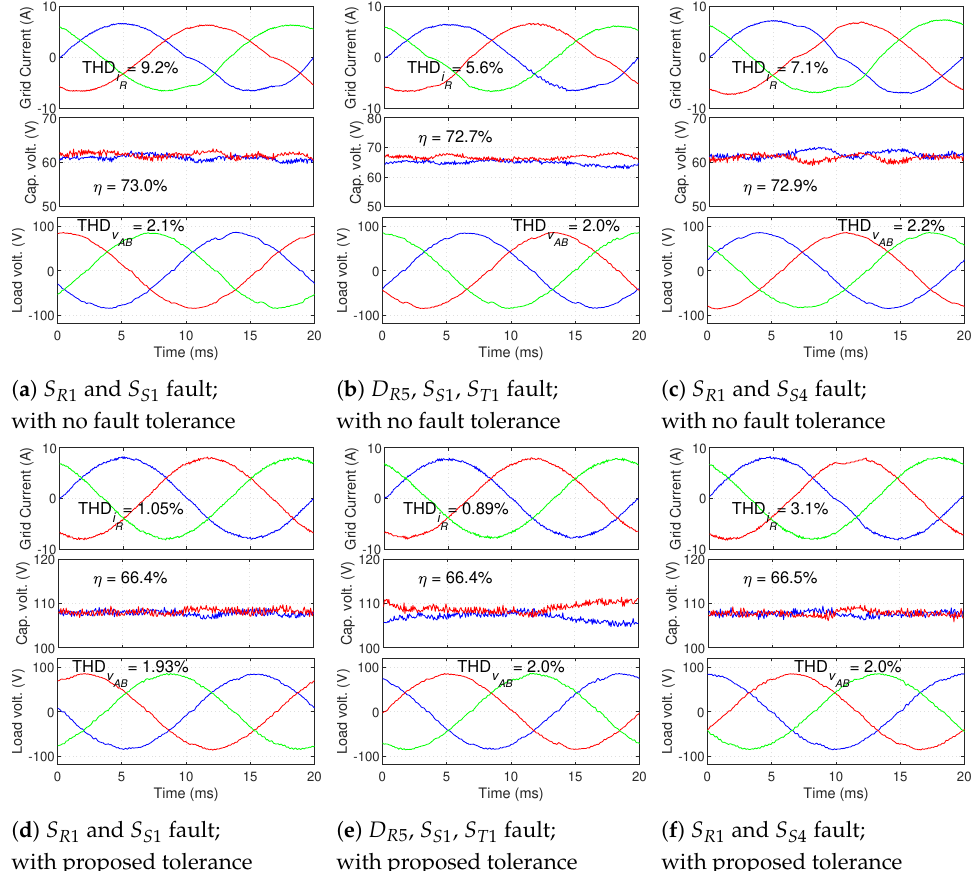
Figure 19. Steady-state operation after several multiple GSC faults, with and without corrective actions. The UPS post-fault performance in each presented case is demonstrated with no corrective action (on top) and with the proposed fault-tolerant mechanism (on the